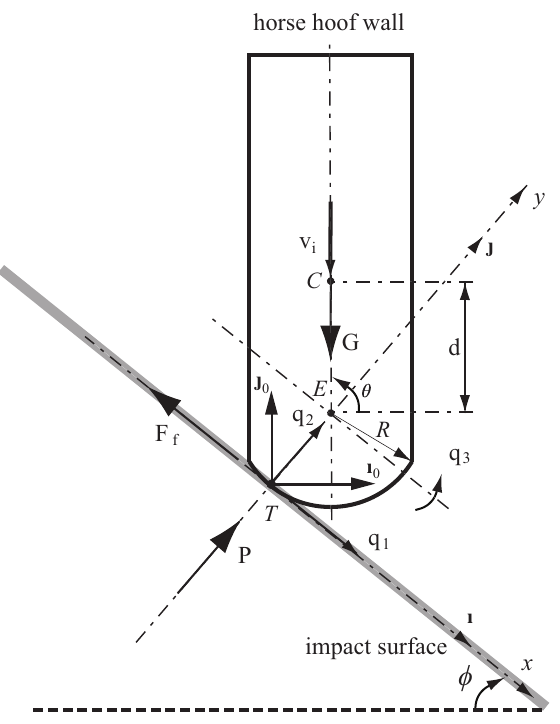
Figure 2. Impact of the hoof wall with a solid